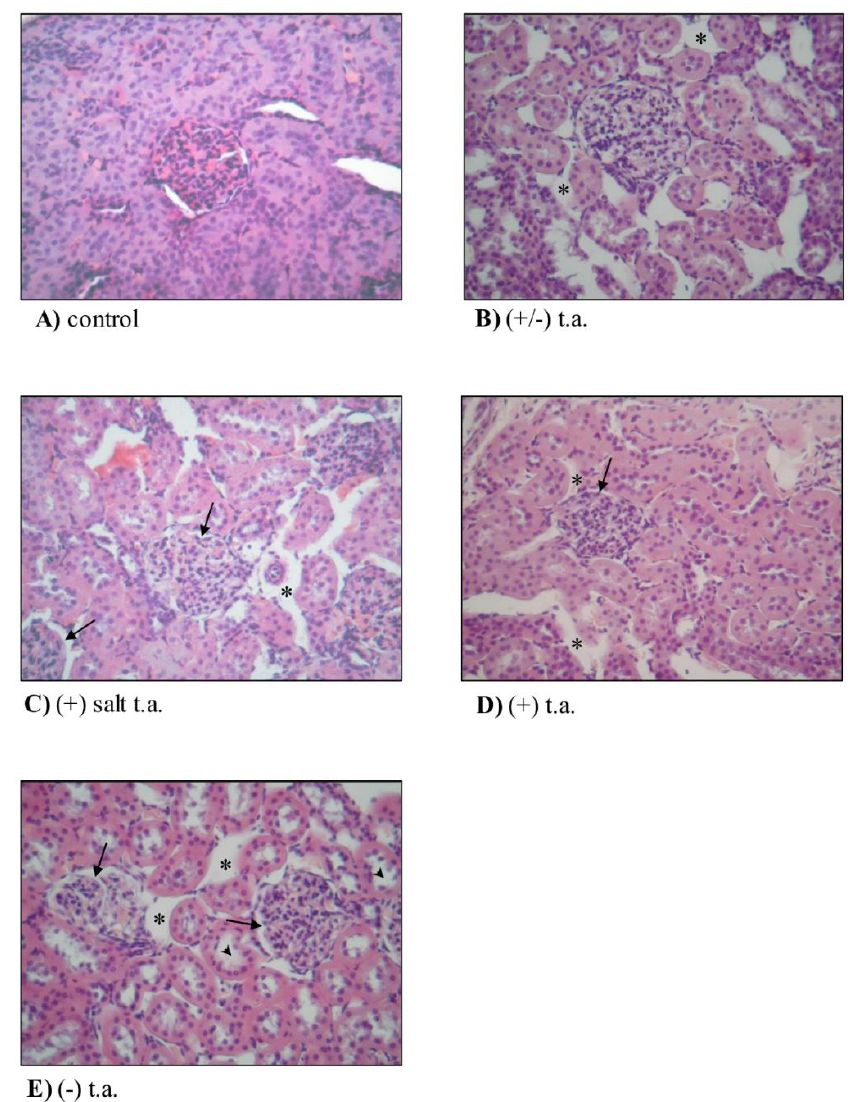
Figure 6. Subchronic toxicity treatments: kidney histology. Effects of 15-day subchronic toxicity treatments with 360-µmol/kg thioctic acid (t.a.) isoforms on histological features of kidney. Histological analysis was performed on kidney samples explanted from rodents treated with ( A ) physiological solution, ( B ) racemic thioctic acid, ( C ) (+) tromethamine salt enantiomer, ( D ) (+) acid enantiomer and ( E ) (−) enantiomer. Asterisks, arrows and arrowheads point to morphological changes. Staining with hematoxylin–eosin technique; original magnification 20×.